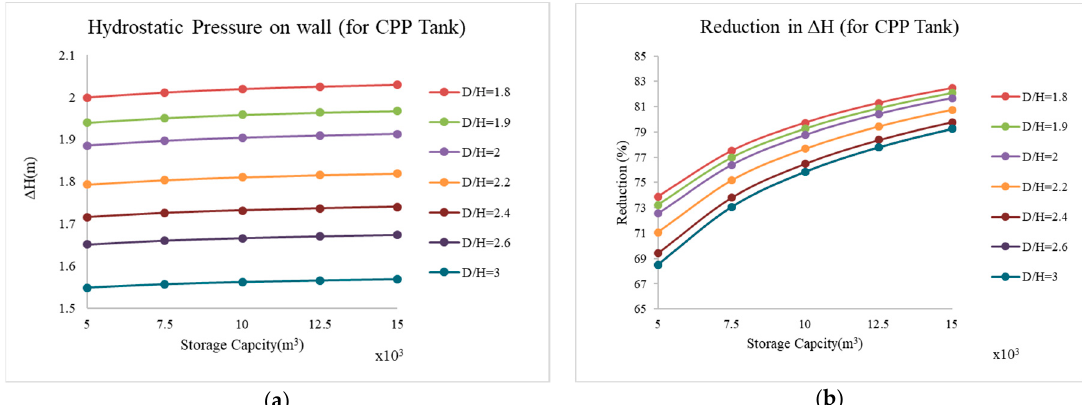
Figure 35. Hydrostatic pressure on cylindrical tank wall: ( a ) maximum pressure head and ( b ) reduction in maximum pressure head.